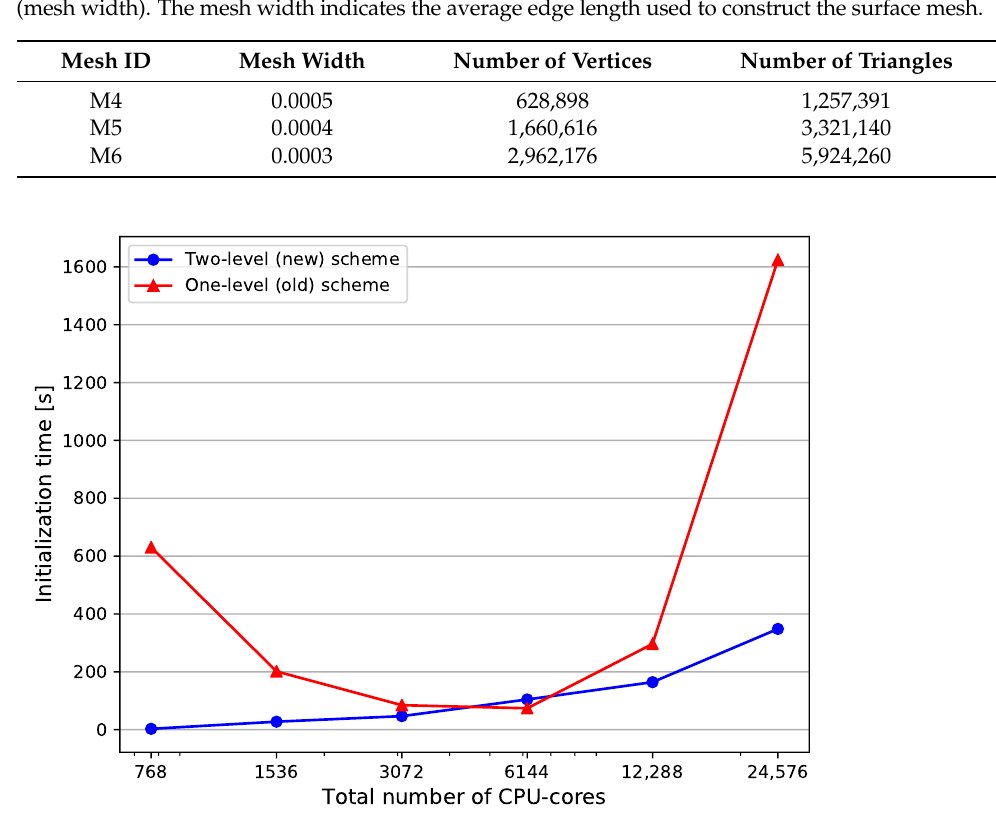
Figure 7. Strong scalability measurements: Total initialization time comparison between the two- level approach and the previously used one-level scheme. A mesh with mesh width 0.005 and 628,898 vertices (Table 1, M4) is used for conducting the